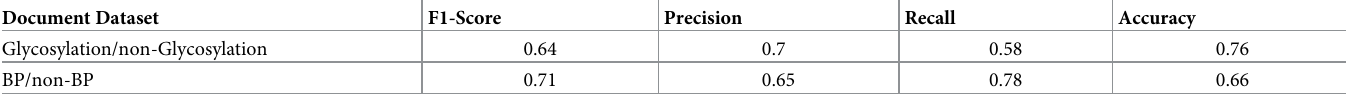
Table 3. Logistic regression utilizing under-sampling and tf-idf with chosen top terms (fraction of majority set =